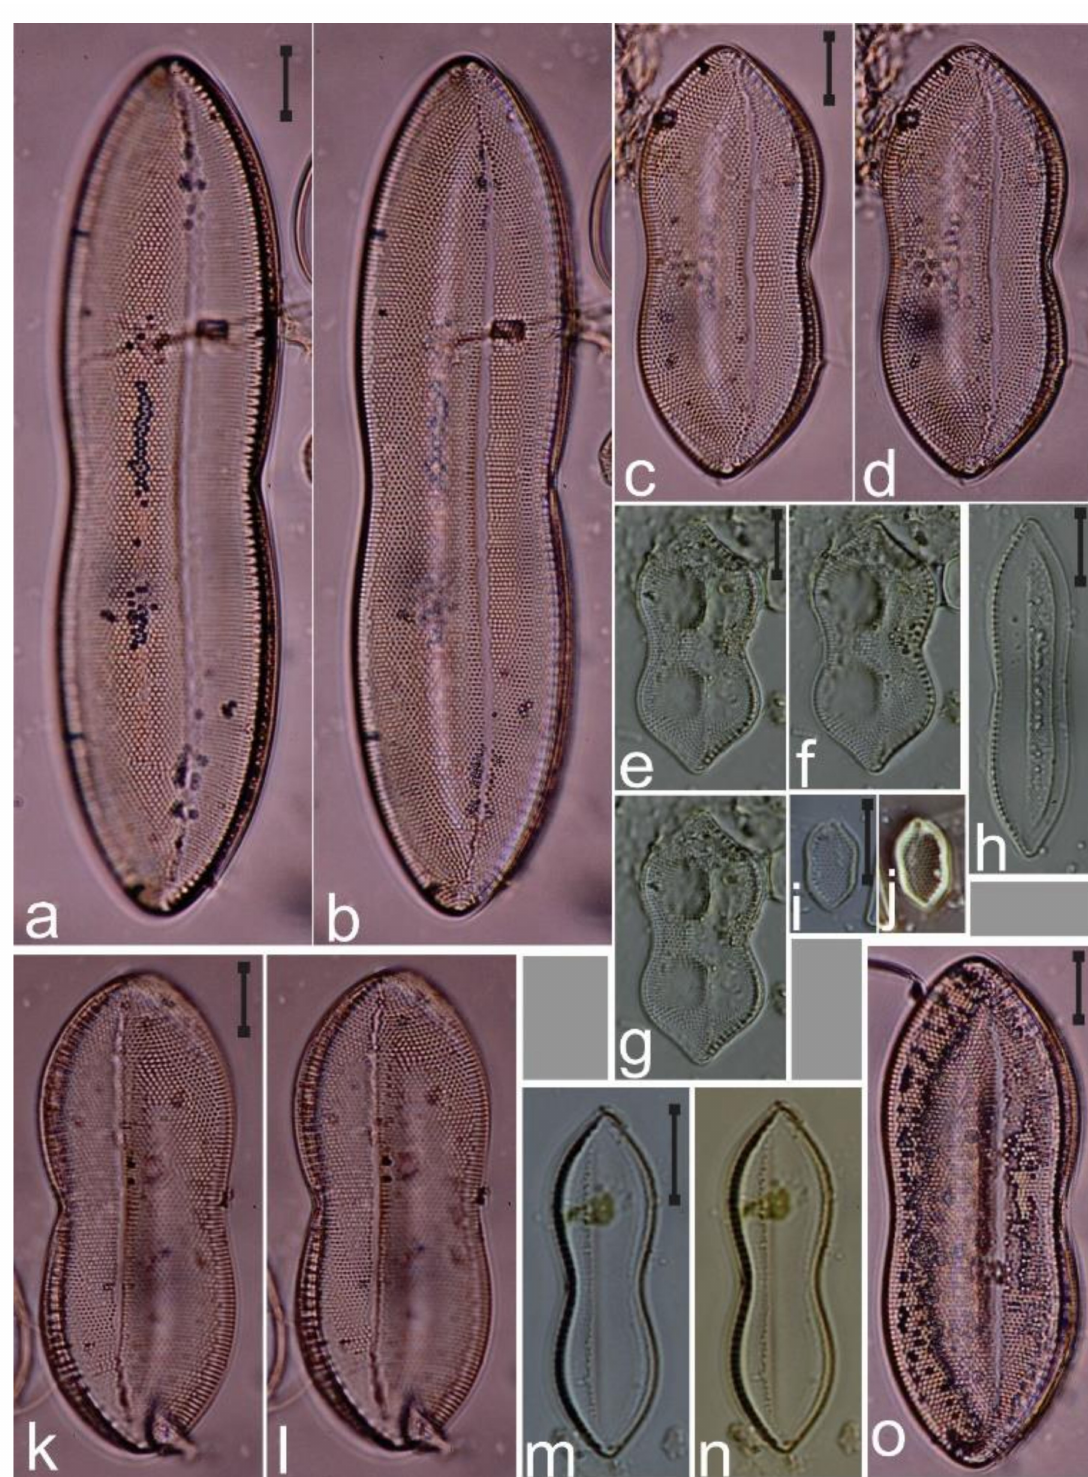
Figure 42. ( a – d , k , l , o ) Psammodictyon panduriforme ; ( e – g ) P. pustulatum ; ( h ) P. roridum ; ( i , j ) P. panduriforme var. continuum ; ( m , n ) Nitzschia carnicobarica . Scale bar = 10 µ